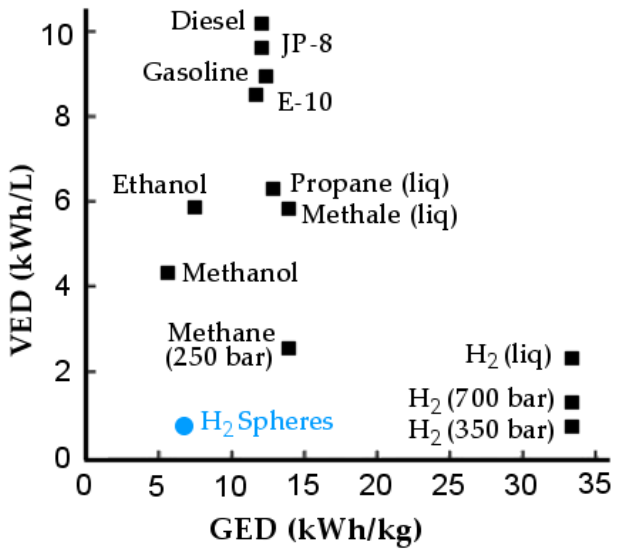
Figure 1. Comparison between GED and VED for the new storage system, taken as a new fuel, and other fuels, adapted by the U.S. Department of Energy.